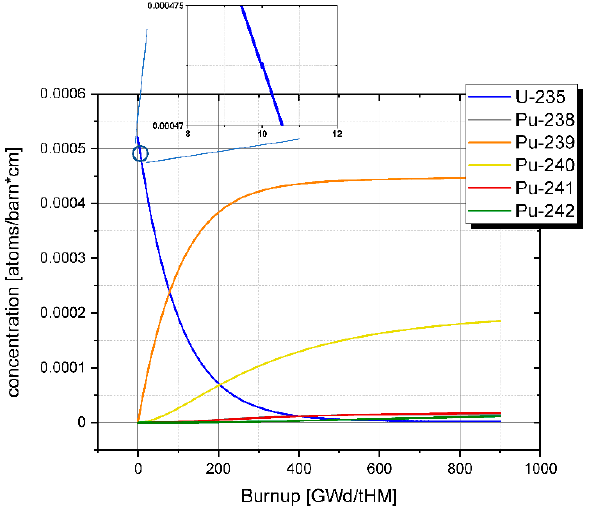
Figure 14. Isotopic inventories over burnup, considering the staggered separation of elements every time the system falls below criticality, based on a simulation using 10 GWd/tHM steps and a clean-up of 20% of the salt after each cycle.